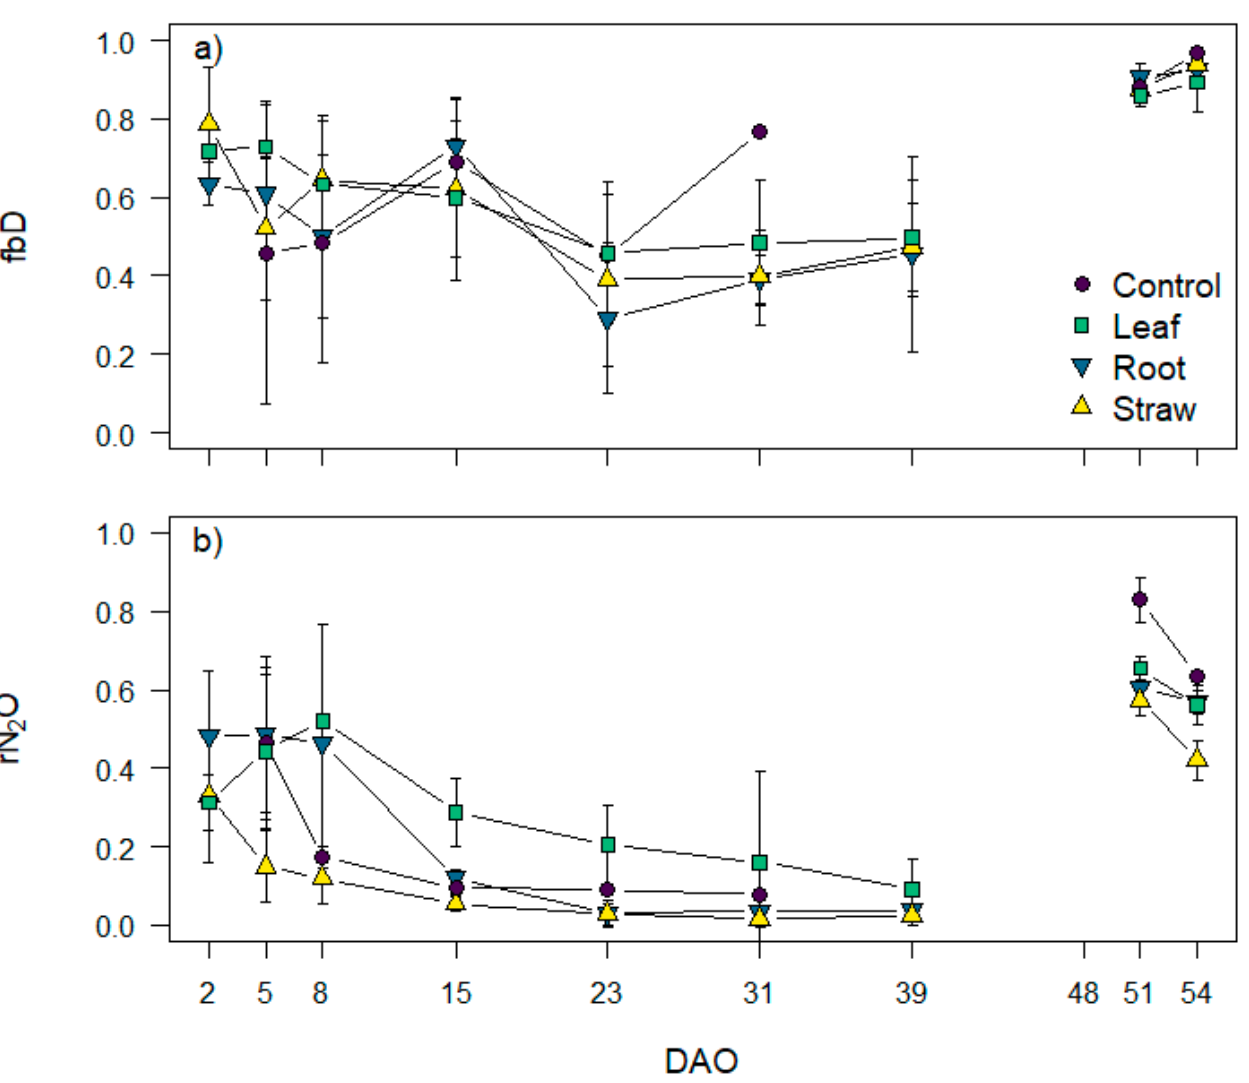
Figure 5. ( a ) Fraction of N 2 O originating from heterotrophic bacterial denitrification/nitrifier denitrification (fbD) and ( b ) fraction of residual unreduced N 2 O (rN 2 O). Values were calculated based on the isotopocule mapping approach by Lewicka-Szczebak et al. (2017) [22] and represent results for scenario 1 (reduction-mixing) of bacterial denitrification with fungal denitrification (mean and standard deviation for n = 5, n = 4 for Control, data points missing for samples with an isotopic signature outside the reduction-mixing area, no N 2 O emitted from Control on 39 DAO).